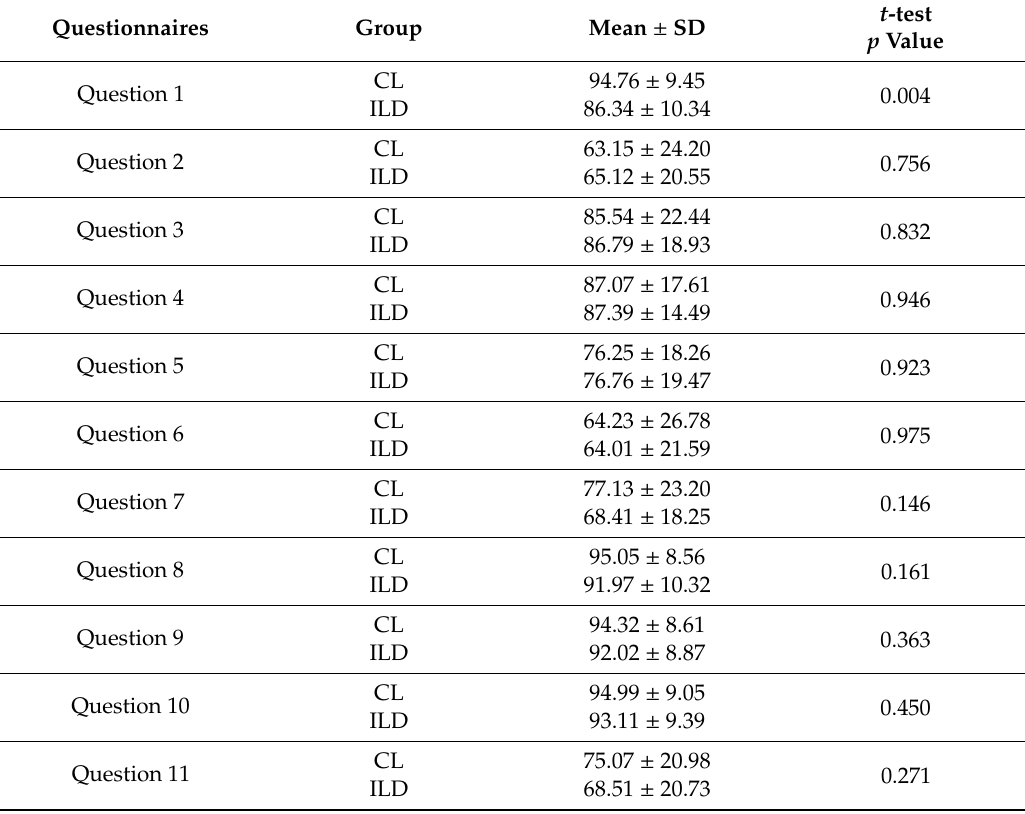
Table 5. Mean and standard deviation of visual analog scale (VAS) score from patient satisfaction.